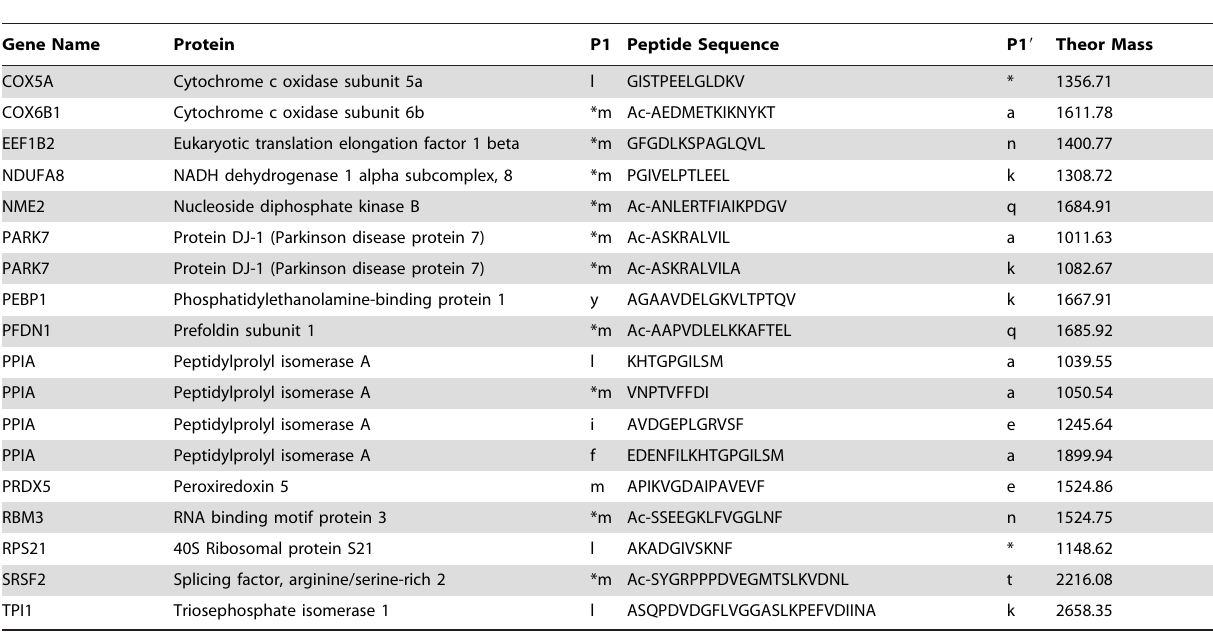
Abbreviations: P1, amino acid residue in the P1 position of the cleavage site used to generate the N-terminus of the peptide; P1 9 , amino acid residue in the P1 9 position of the cleavage site used to generate the C-terminus of the peptide; *, end of protein; *m, initiation methionine; Theor Mass, theoretical mass of the peptide; Ac-, acetyl. The amino acid sequence uses the standard single letter code and is indicated in upper case for the sequence of the peptide that was identified, and lower case for the peptide’s flanking sequences in the precursor protein.